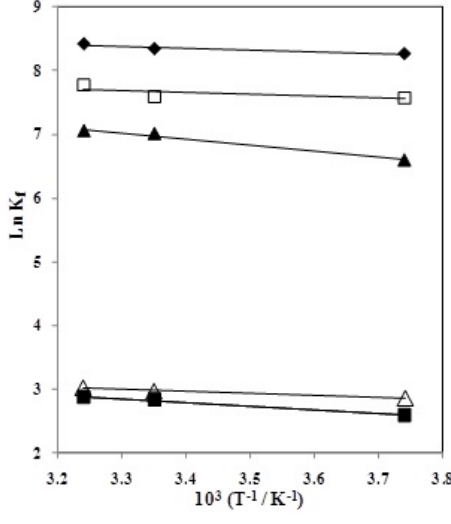
Figure 5. Van’t Hoff plots for the 1:1 complexation of Ti(OH)(OH CMCR in AN–H O binary systems: (mol% AN: ♦ 100, □ 57.95, ▲ 34.09, ∆ 18.68, ■ 2